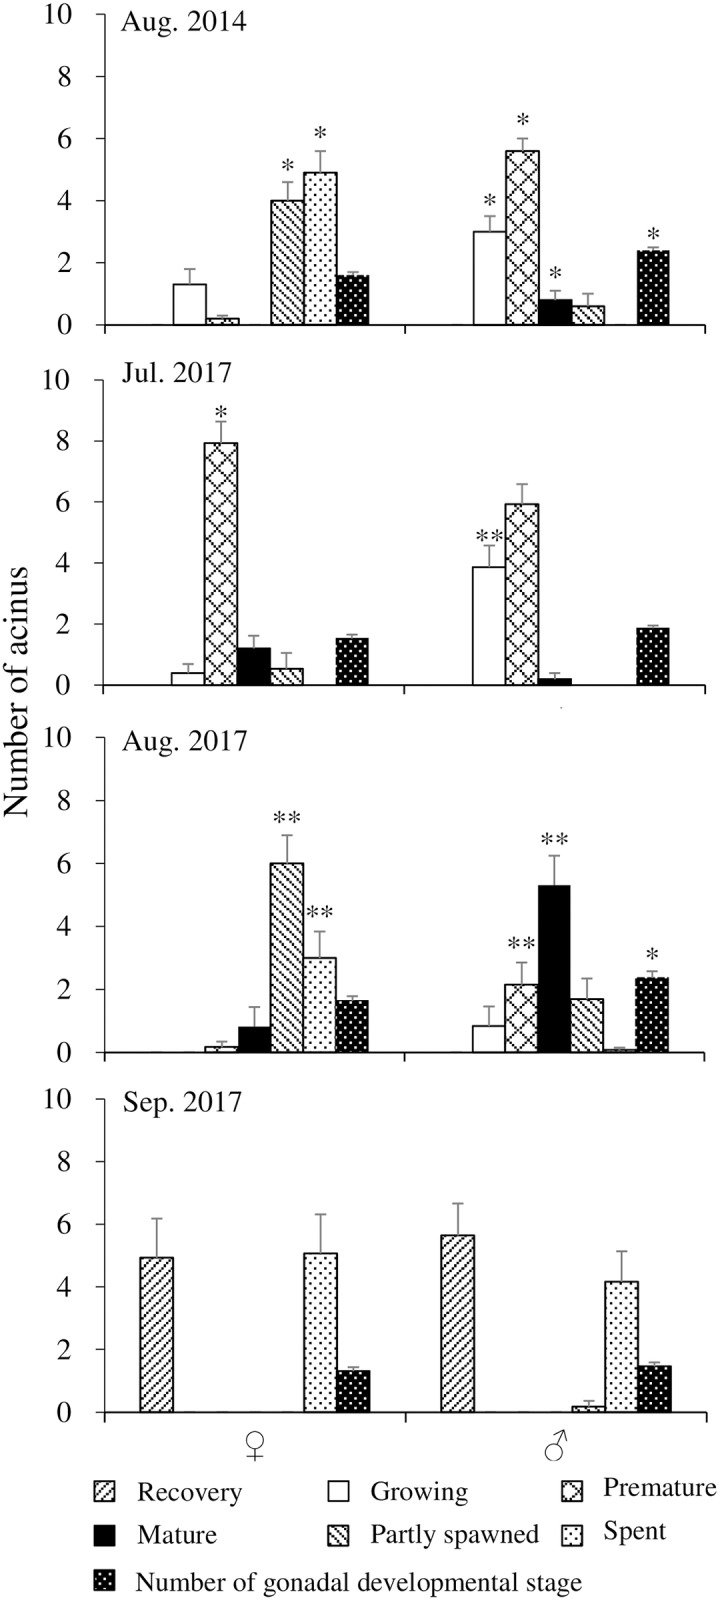
Number of acini at different gonad development stages per 10 acini and number of gonad developmental stage of Heliocidaris crassispina by sex in August 2014 and July–September 2017.Data indicate means ± SE. One and two asterisks indicate significant sexual differences at p < 0.05 and p < 0.01, respectively.